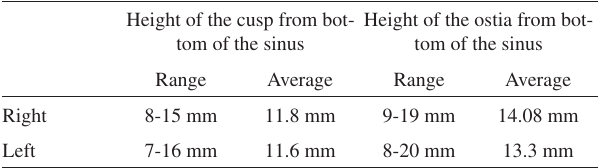
Table 3 - The heights of the cusps and the coronary ostia were measured from the bottom of the sinus Height of the cusp from bot- tom of the sinus